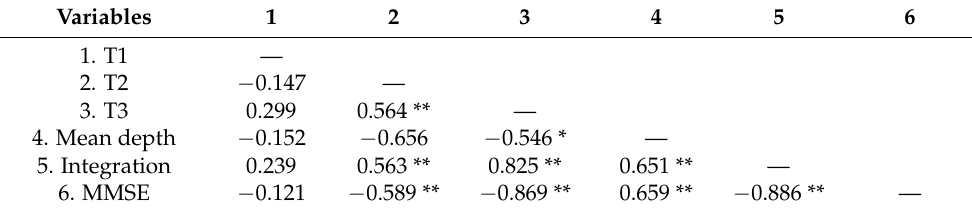
Table 4. Analysis of correlation between the different task completion times and spatial properties. Variables